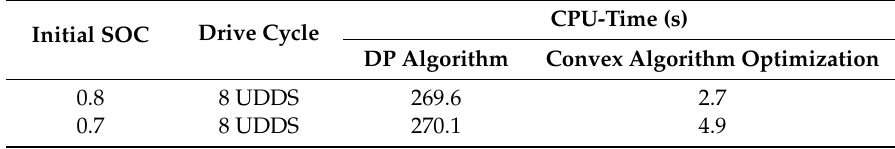
Table 6. Results comparison with different initial